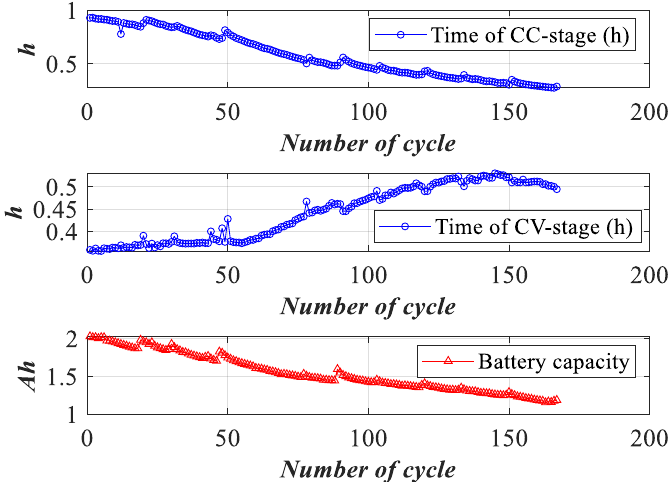
Figure 5. Observation indicators of a lithium-ion battery.